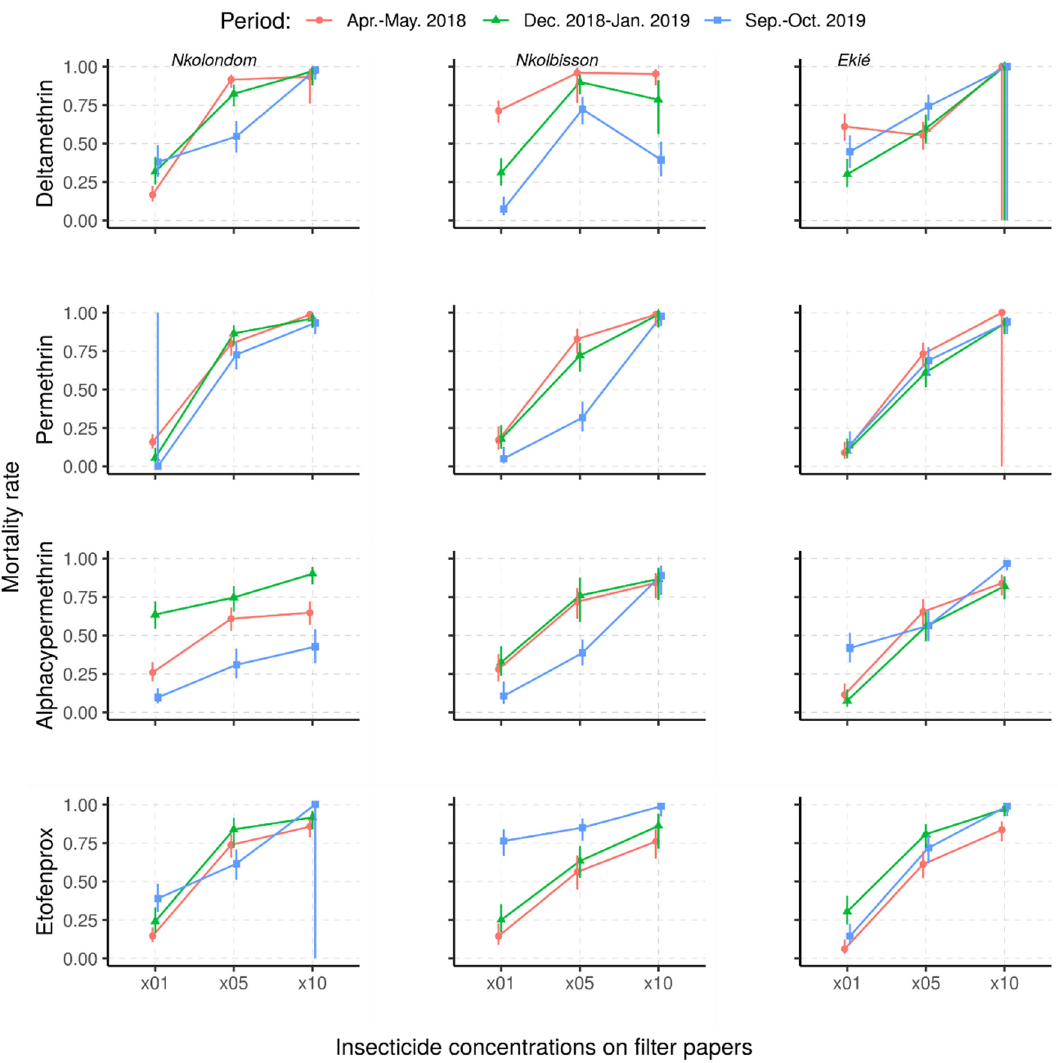
Figure 4. Predicted mortality rates and their 95% confidence intervals of field-collected Anopheles gambiae s.l. samples from a mixed-effects logistic regression model following exposure to 1×, 5× and 10× insecticide concentrations (Apr.-May 2018: April–